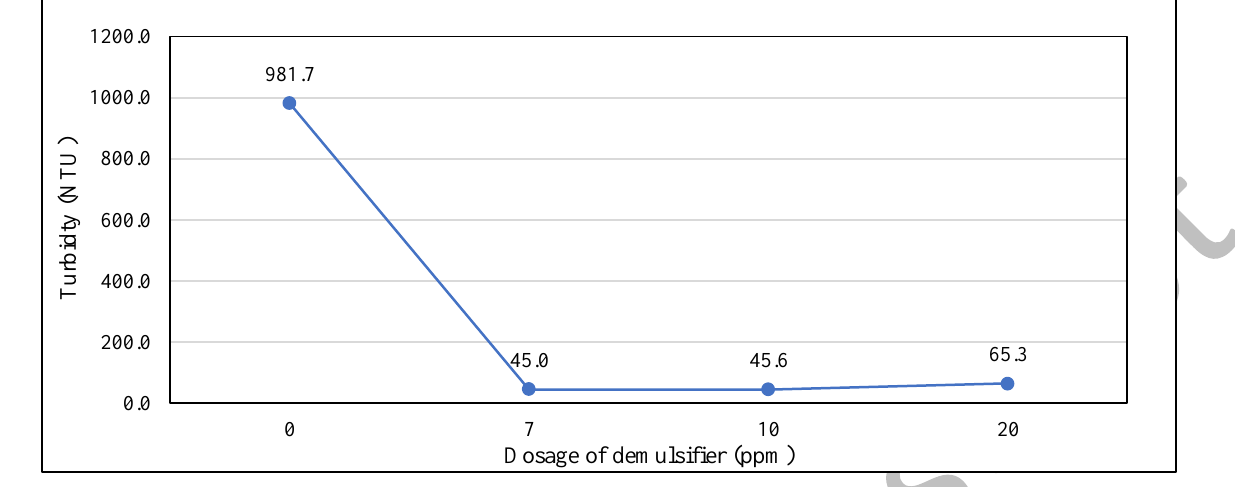
Fig. 6–Impact of demulsifier DB on the turbidity of treated produced water sample at 60 °C